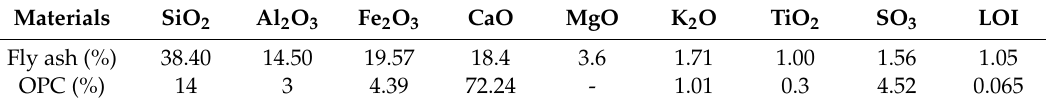
Table 1. Chemical composition of fly ash and ordinary Portland cement (OPC).